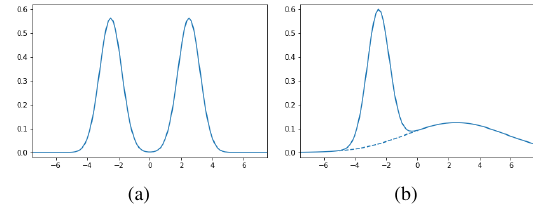
Figure 7. Example for the degradation of the Hellinger distance. The Hellinger distance is 0 . 99 for both shown Gaussian kernels (a). It degrades to 0 . 64 once the variance of the second kernels is greatly increased (b).